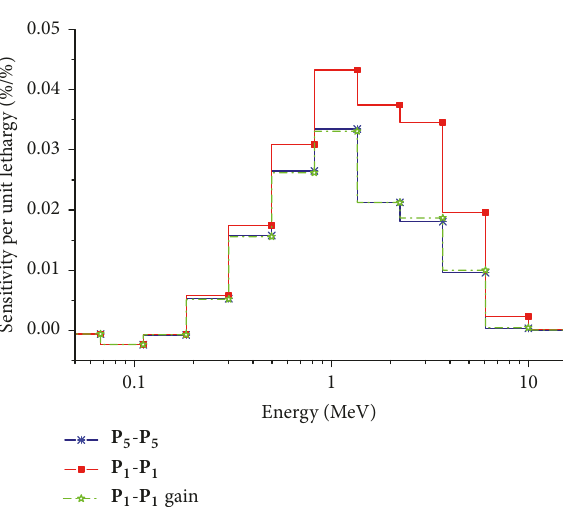
Figure 3: Sensitivity of 𝑘 eff to 238 U elastic cross-sections calculated by SUSD3D/ANISN codes. P 5 -P 5 = P 5 transport & sensitivity calculation, P 1 -P 1 = P 1 transport using BHS cross-sections and P 1 sensitivity, P 1 -P 5 = P 1 transport using BHS, P 5 sensitivity calculations, P 1 -P 1 gain=P 1 transportusingBHScross-sections,and sensitivity calculation using (2) with P 1 gain term.